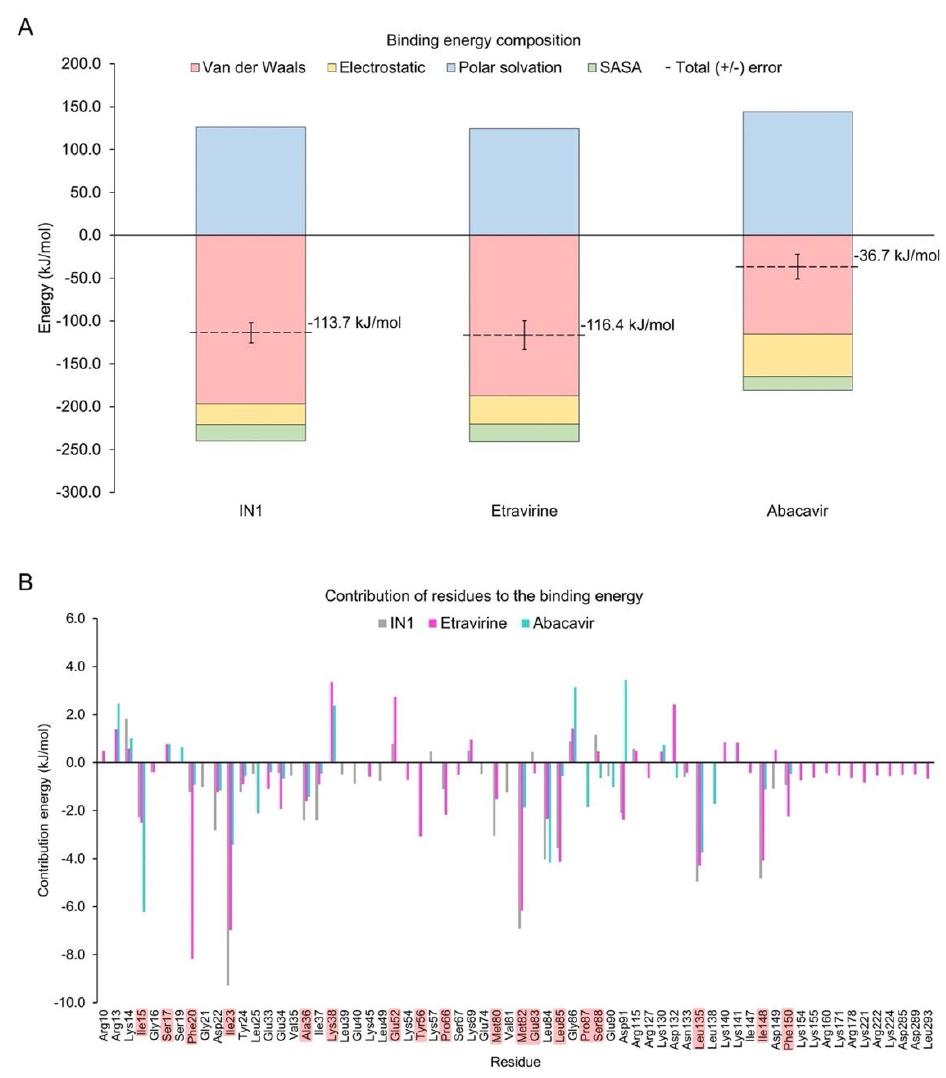
Figure 7. Binding energy-analysis. ( A ) Energy decomposition from systems with etravirine or abacavir were calculated from MD simulations. The system with IN1 is included for comparison. ( B ) Per-residue energy decomposition. Highlighted residues are part of the catalytic domain.